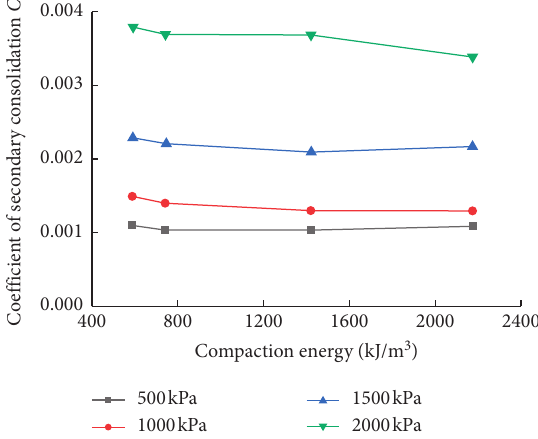
� 592.2kJ/m 3 and σ � 1500kPa. 0